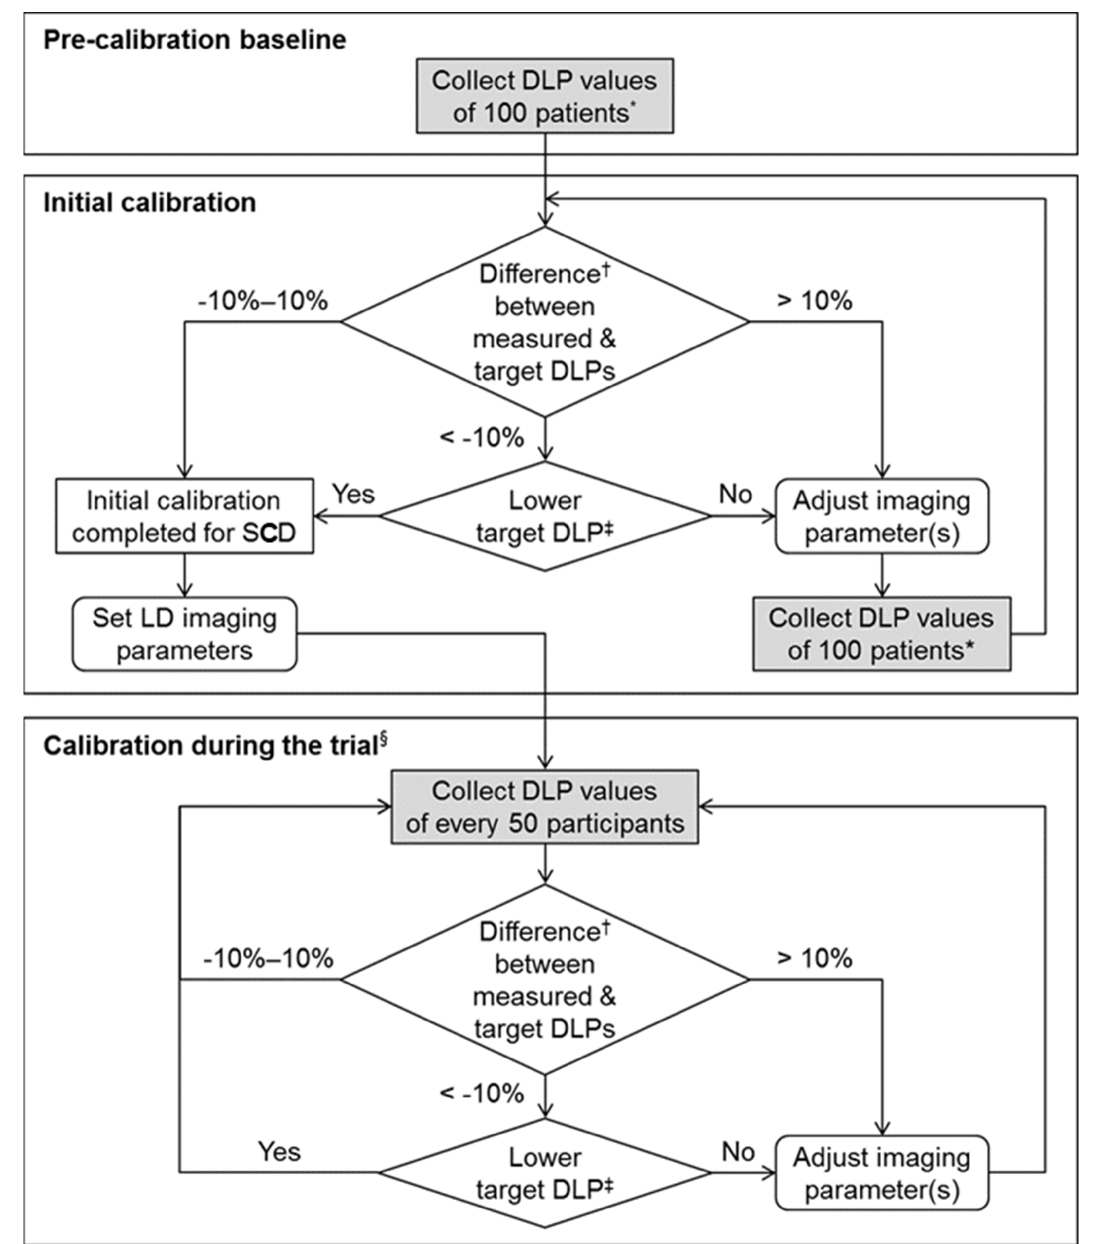
Figure 2. Radiation dose calibration procedures for each CT machine. * In regular abdomen CT examinations for various purposes in patients not enrolled in the trial. † Difference (%) = (measured median DLP—target DLP) / target DLP × 100. ‡ At the discretion of the lead radiologist. § For each of conventional-dose and low-dose groups. DLP = dose-length product, LD = low dose, SCD = site of conventional dose.